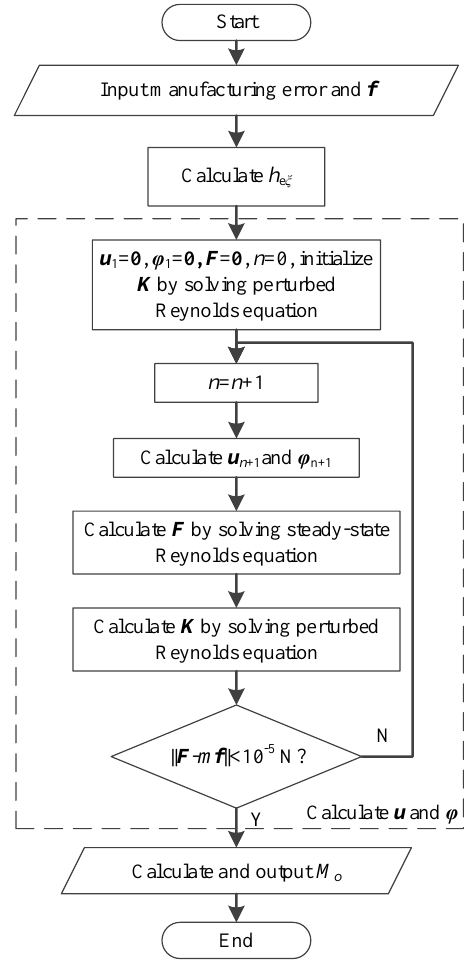
Figure 8. Program flow chart for calculating interference torque.